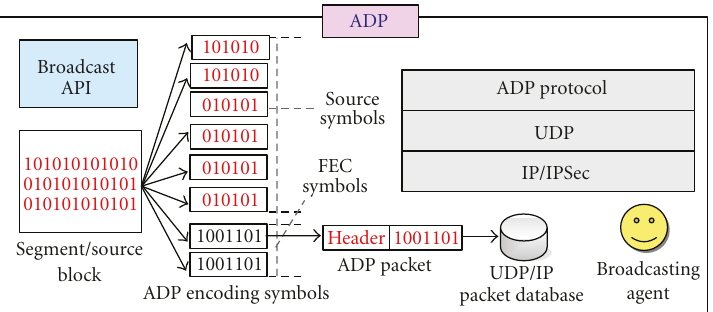
Figure 6: The ADP packets generation and UDP/IP